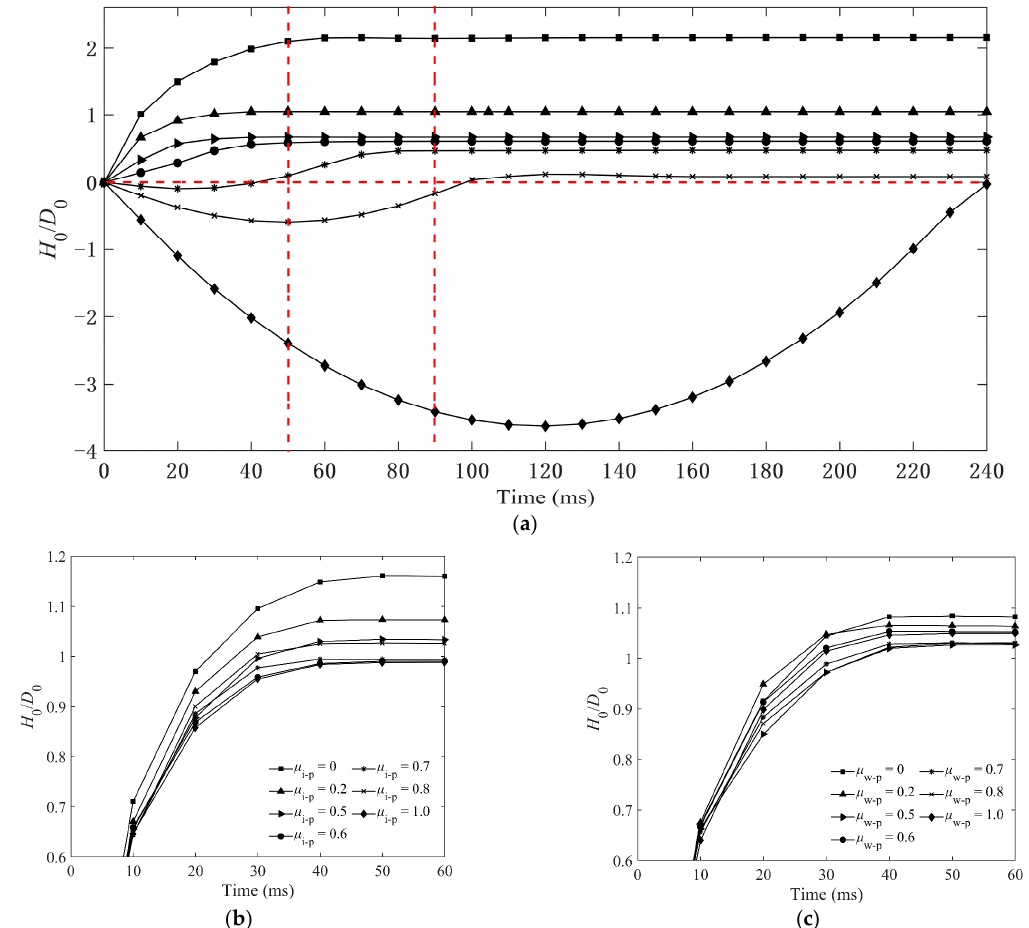
Figure 14. Time evolution of the non-dimensional penetration depth H 0 / D 0 of impacting into the granular bed of L p = 6 mm particles: ( a ) condition Ⅰ , ( b ) condition Ⅱ, and ( c ) condition Ⅲ . H 0 and D 0 represent the penetration depth and diameter of impactor, respectively. Condition Ⅰ : μ i-p = 0.2, μ w-p = 0.34 and various μ p-p s; condition Ⅱ : μ p-p = 0.2, μ w-p = 0.34 and various μ i-p s; condition Ⅲ : μ p-p = 0.2, μ i-p = 0.2 and various μ w-p s. (The dotted lines are used to clearly mark the position of the impactor at different times.)